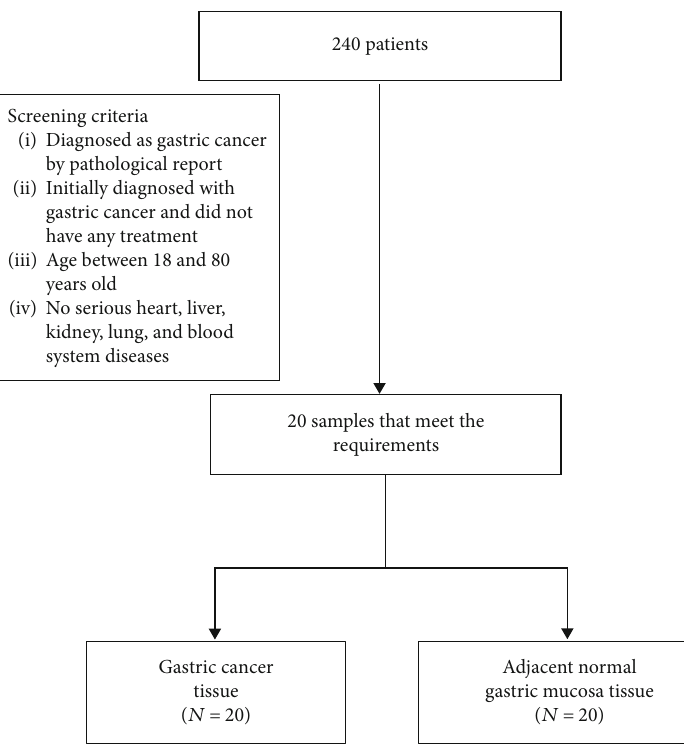
Figure 1: STARD fl owchart of the process used to recruit the study